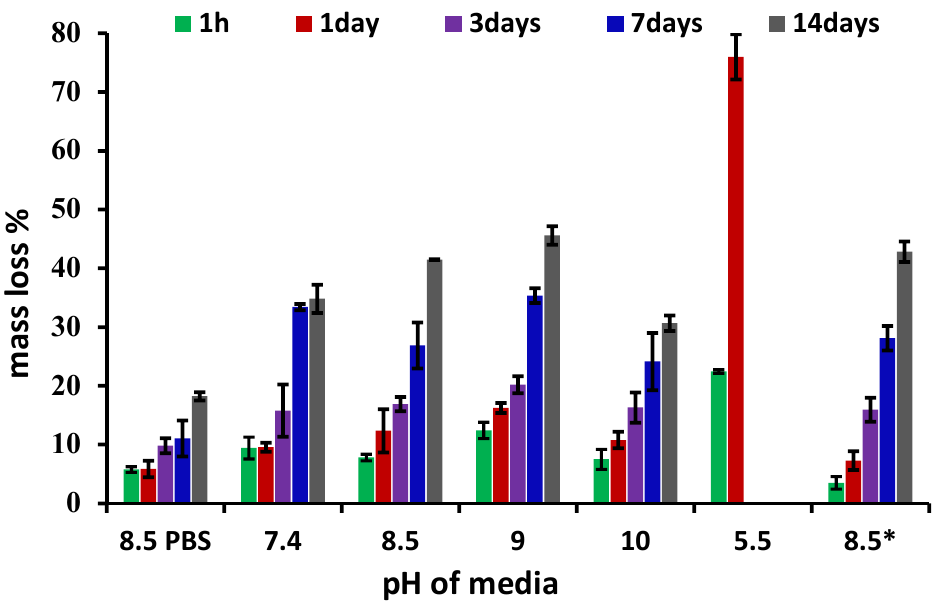
Figure 6. The mass loss of hydrogel over 14 days, in lysozyme media (376 U/mL) of different pH (* indicates a lysozyme concentration of 4830 U/mL; 8.5PBS indicates the absence of lysozyme).